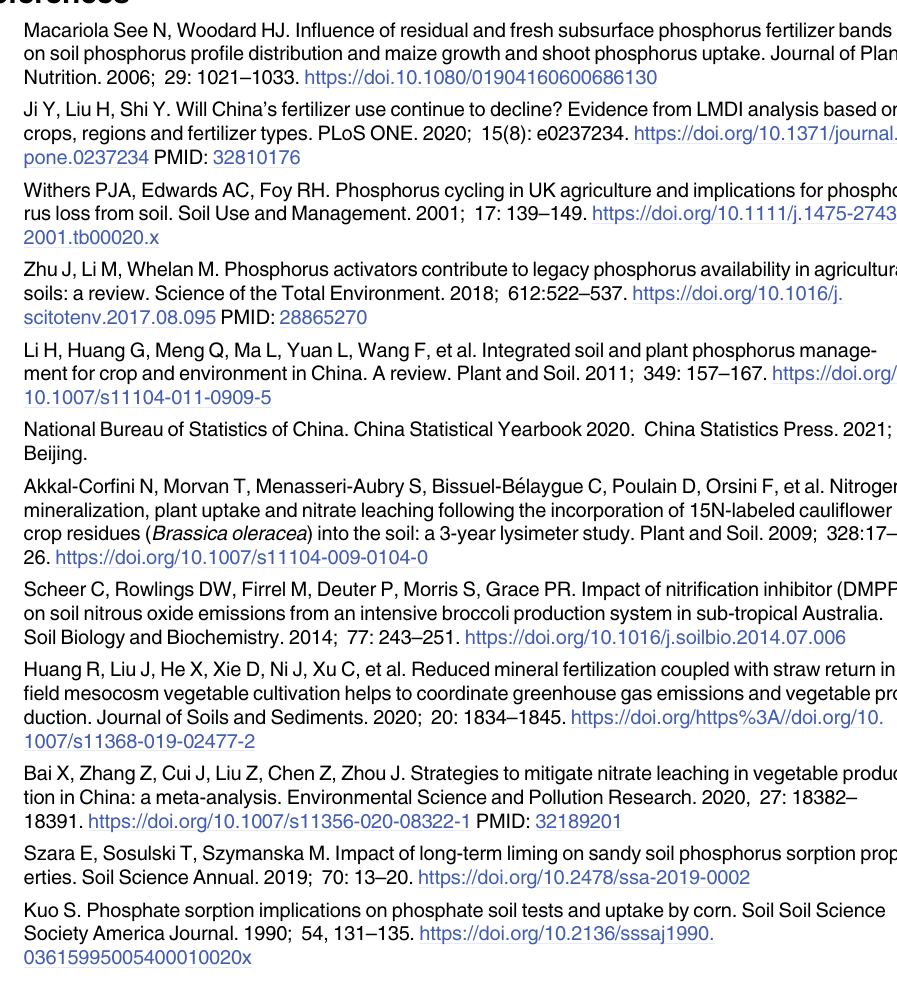
S7 Table. Original data for Fig 4 phosphorus (P) adsorption isotherms in soil from differ- ent fields (n =